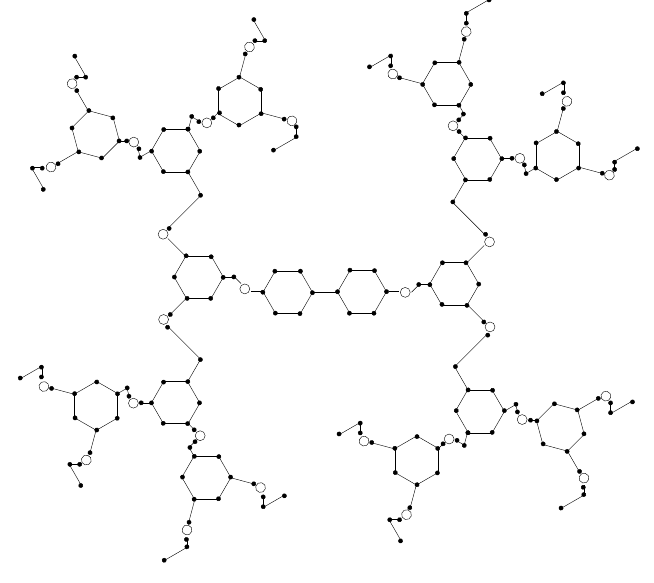
Figure 4. The graph of polyaryl ether dendrimer G 1 ( 2